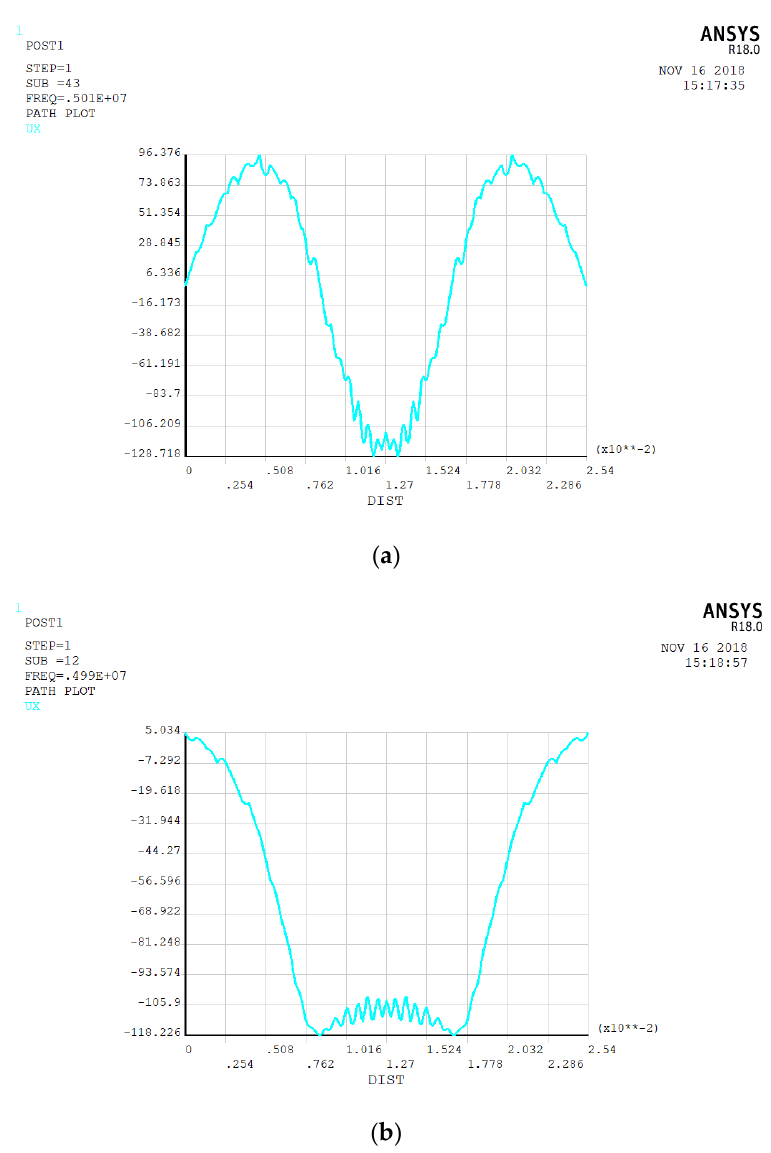
Figure 3. ( a ) The vibration displacement curve of the chip along the radius corresponds to Figure 2a; ( b ) the vibration displacement curve of the chip along the radius corresponds to Figure 2b.